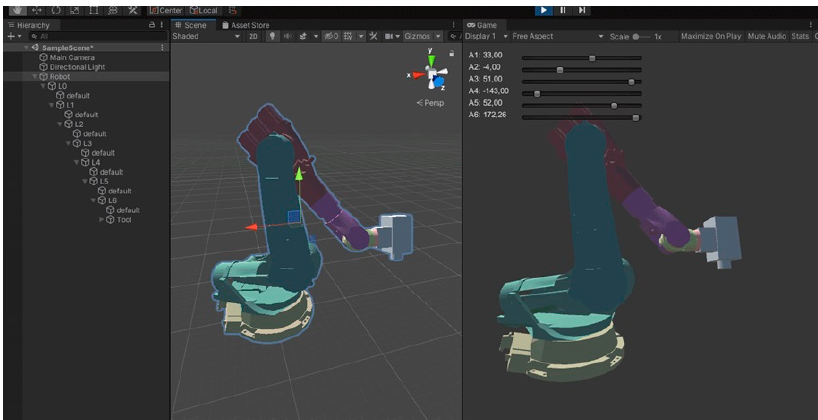
Figure 8. Kuka KR210 simulation inside Unity Game Engine.